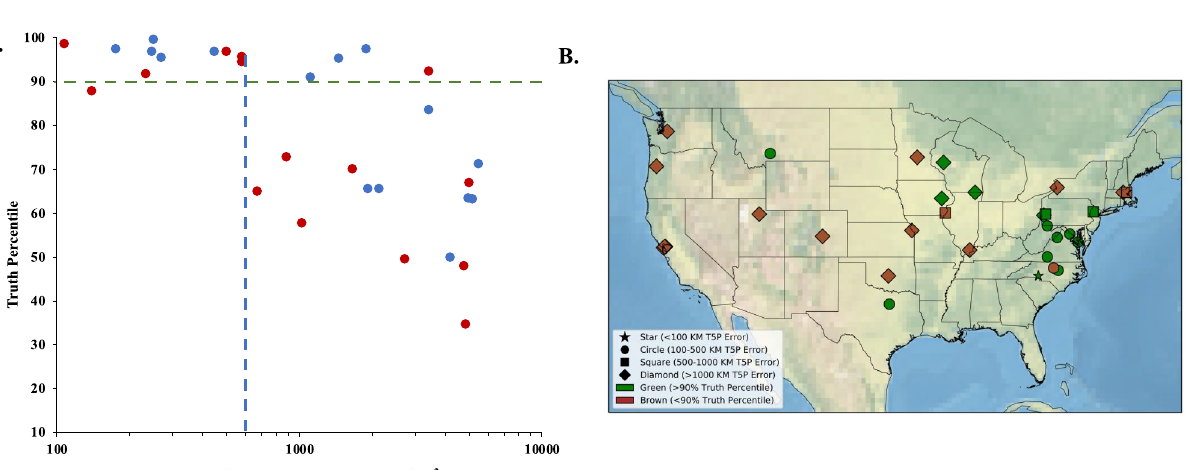
Figure 5. Correlation of total mapped OTU in a sample to its attribution accuracy metrics. Dust samples collected after 14-day exposure in MA (gray), FL (blue), NM (red), or SC (orange) were subject to plant metabarcoding and the resulting OTUs were mapped using our attribution pipeline. ( A ) Relationship between mapped OTU and TP, with a 90% TP cutoff indicated. ( B ) Relationship between mapped OTU and AT5PE, with a 600 km cutoff indicated.